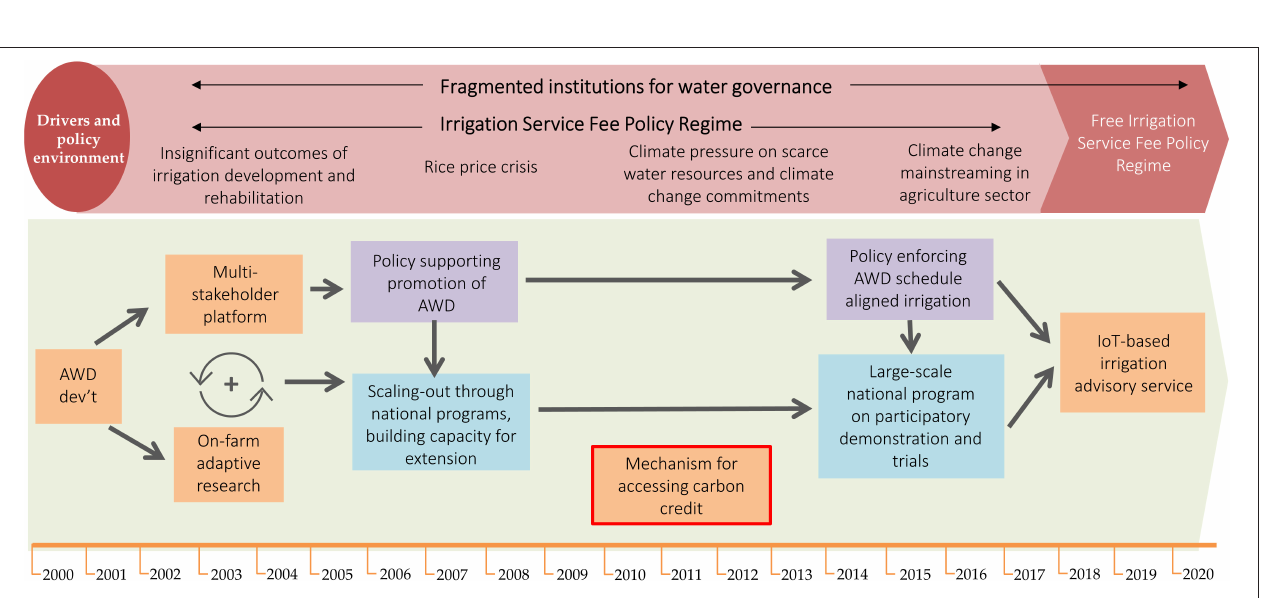
Frontiers in Sustainable Food Systems |